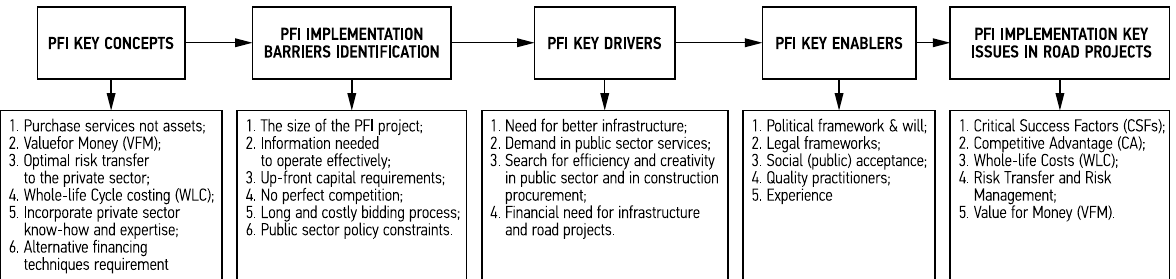
Fig. 2. PFI Framework for road